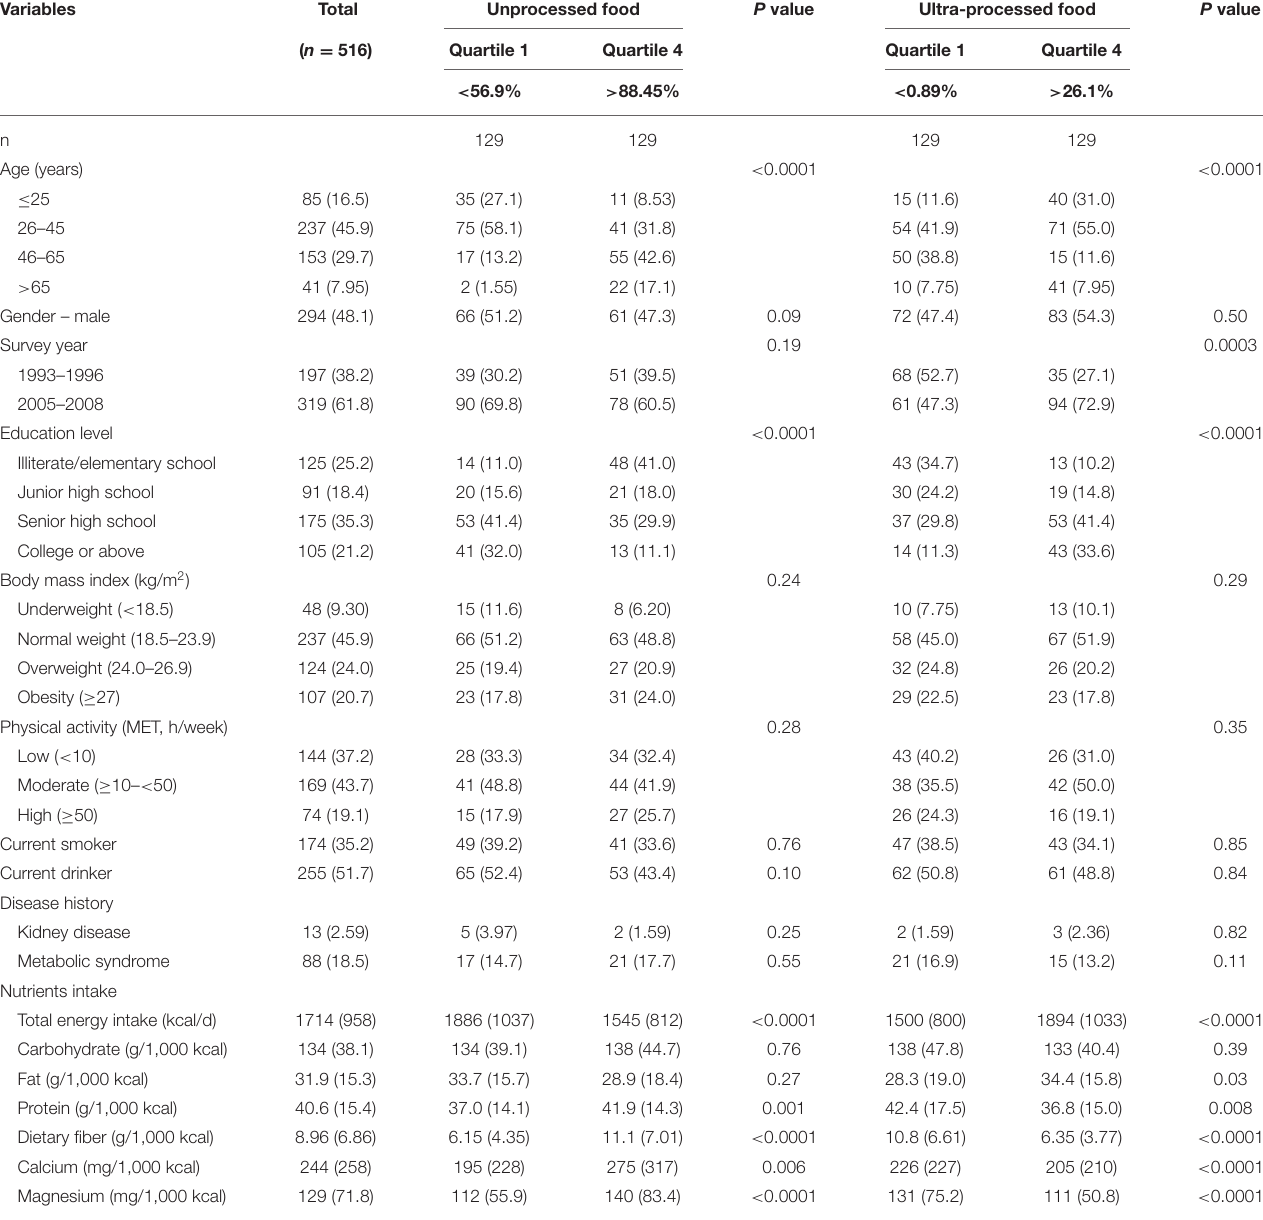
TABLE 1 | Baseline characteristics of study participants by quartiles of unprocessed and ultra-processed food